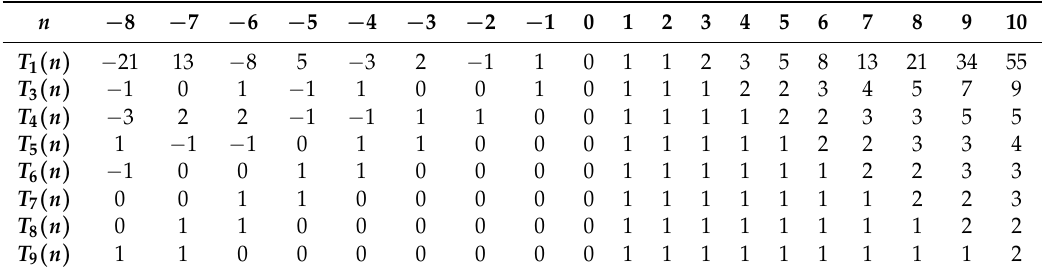
Table 2. Values T q ( n ) for q = 1,3,4,5,6,7,8,9 and − 8 ≤ n ≤